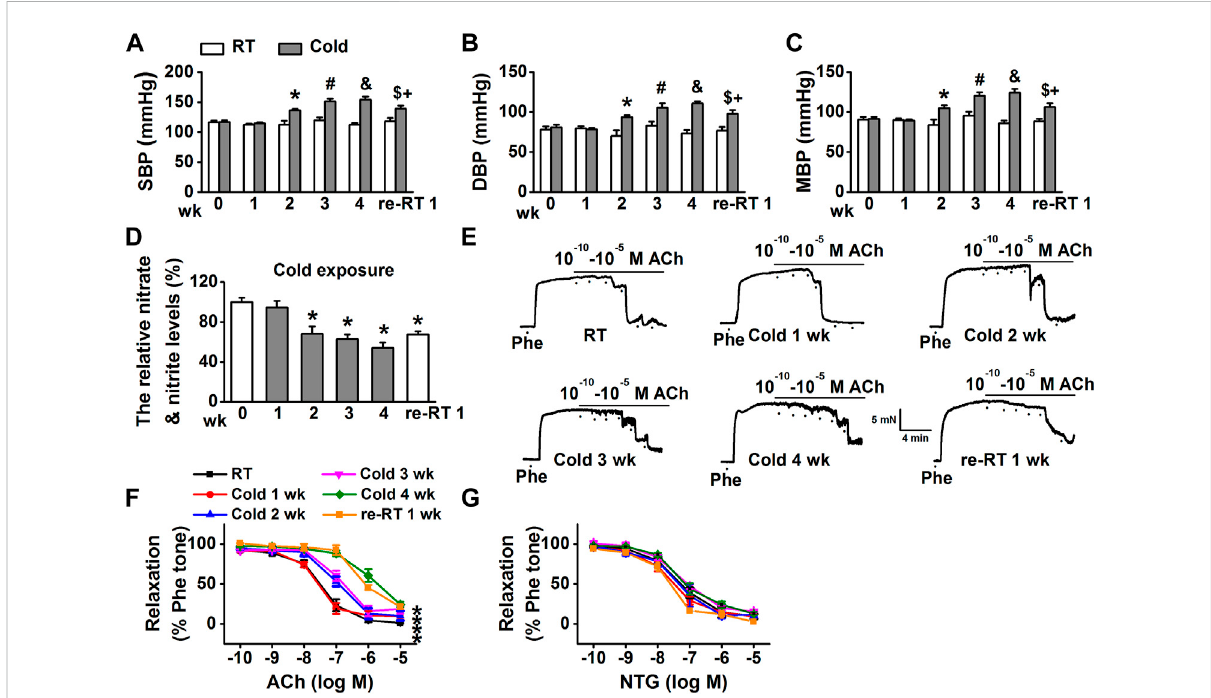
FIGURE 1 Coldexposureincreasedbloodpressure,decreasedNOproduction,andimpairedEDR. (A – C) SBP,DBP,andMBPwere,respectively,measured before and after cold exposure at 1, 2, 3, 4 weeks, and at 5th week kept in RT (re-RT) ( n = 5 – 8 rats for each group; * p < 0.05 vs. RT at 2 weeks; # p < 0.05 vs. RT at 3 weeks; & p < 0.05 vs. RT at 4 weeks; $ p < 0.05 vs. cold at 4 weeks; + p < 0.05 vs. RT at re-RT 1 week). (D) Concentration of nitrate and nitrite,anindirectindicationofNOlevelsinmesentericarteries(MAs),was,respectively,measuredindissectedmesentericvascularbeds,under the control conditions and after cold exposure for 1, 2, 3, 4 weeks, and re-RT 1 week ( n = 5 for each group; * p < 0.05 vs. control). (E) Representative traces of endothelium-dependent relaxation (EDR) of MA rings; the rings were, respectively, isolated from control rats and the cold-exposed rats at theindicated time. The MA ringswere precontracted with 10 μ Mphenylephrine(Phe) before the application of0.1 nM to 10 μ Macetylcholine (ACh). (F) Summarized percent changes of EDR obtained from the experiments as shown in (E) ( n = 5 – 6 for each group; * p < 0.05 vs. control).